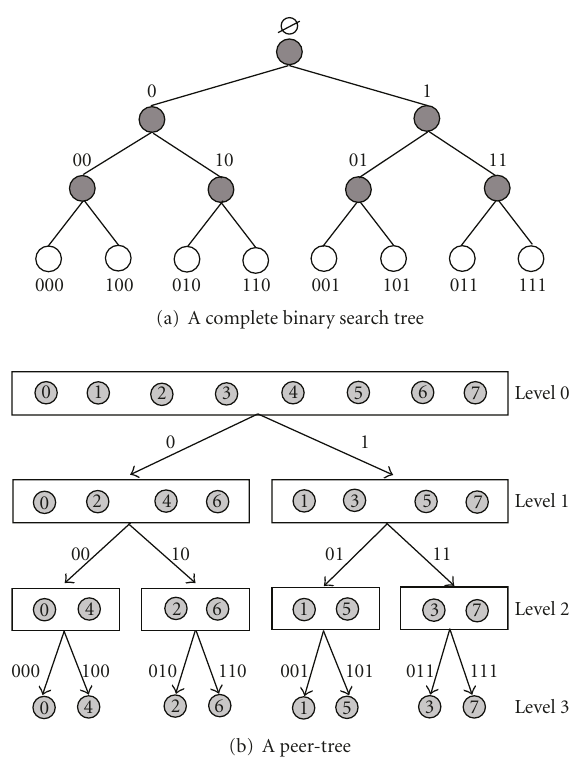
Figure 1: Illustration of a peer-tree built on identifiers of 8 mobile wireless hosts. Each leaf node represents the identifier of a host, and each internal node represents a set of identifiers sharing a common su ffi x. Each internal node is labeled by the common su ffi x of identifiers included in